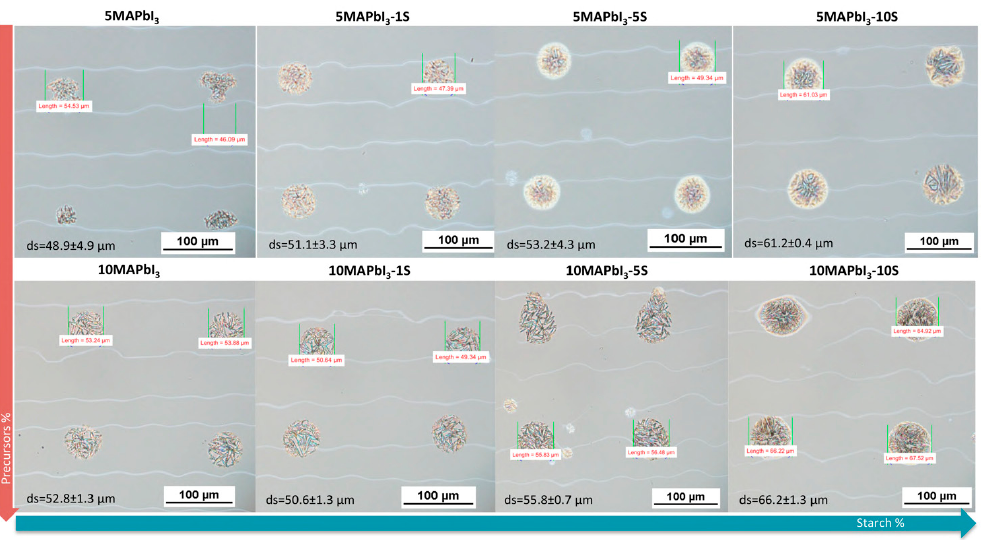
Figure 3. Single droplets of the inks deposited on printed and annealed poly-TPD by varying perovskite precursors and starch concentrations.